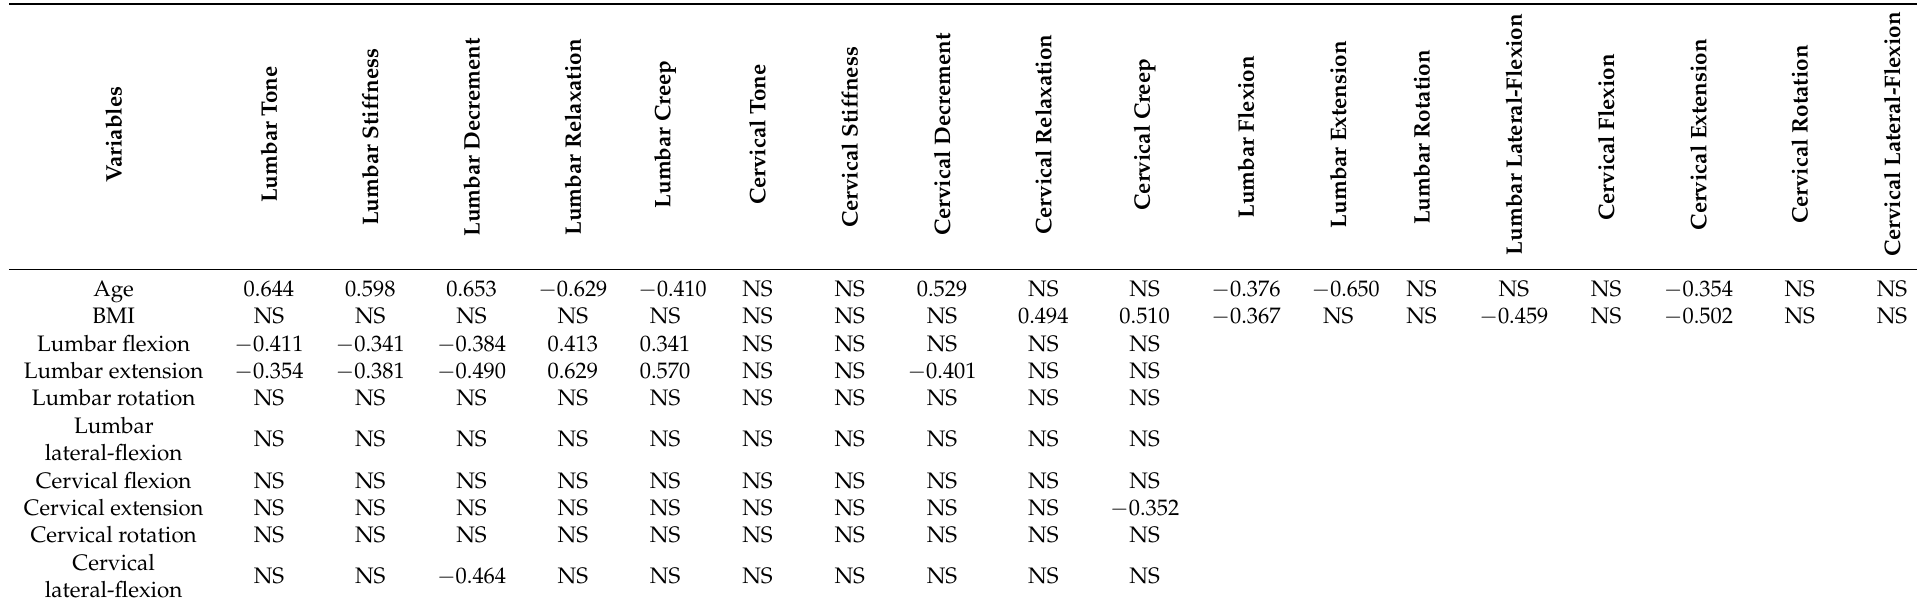
Table 5. Correlations between sociodemographic and clinical characteristics within the healthy control